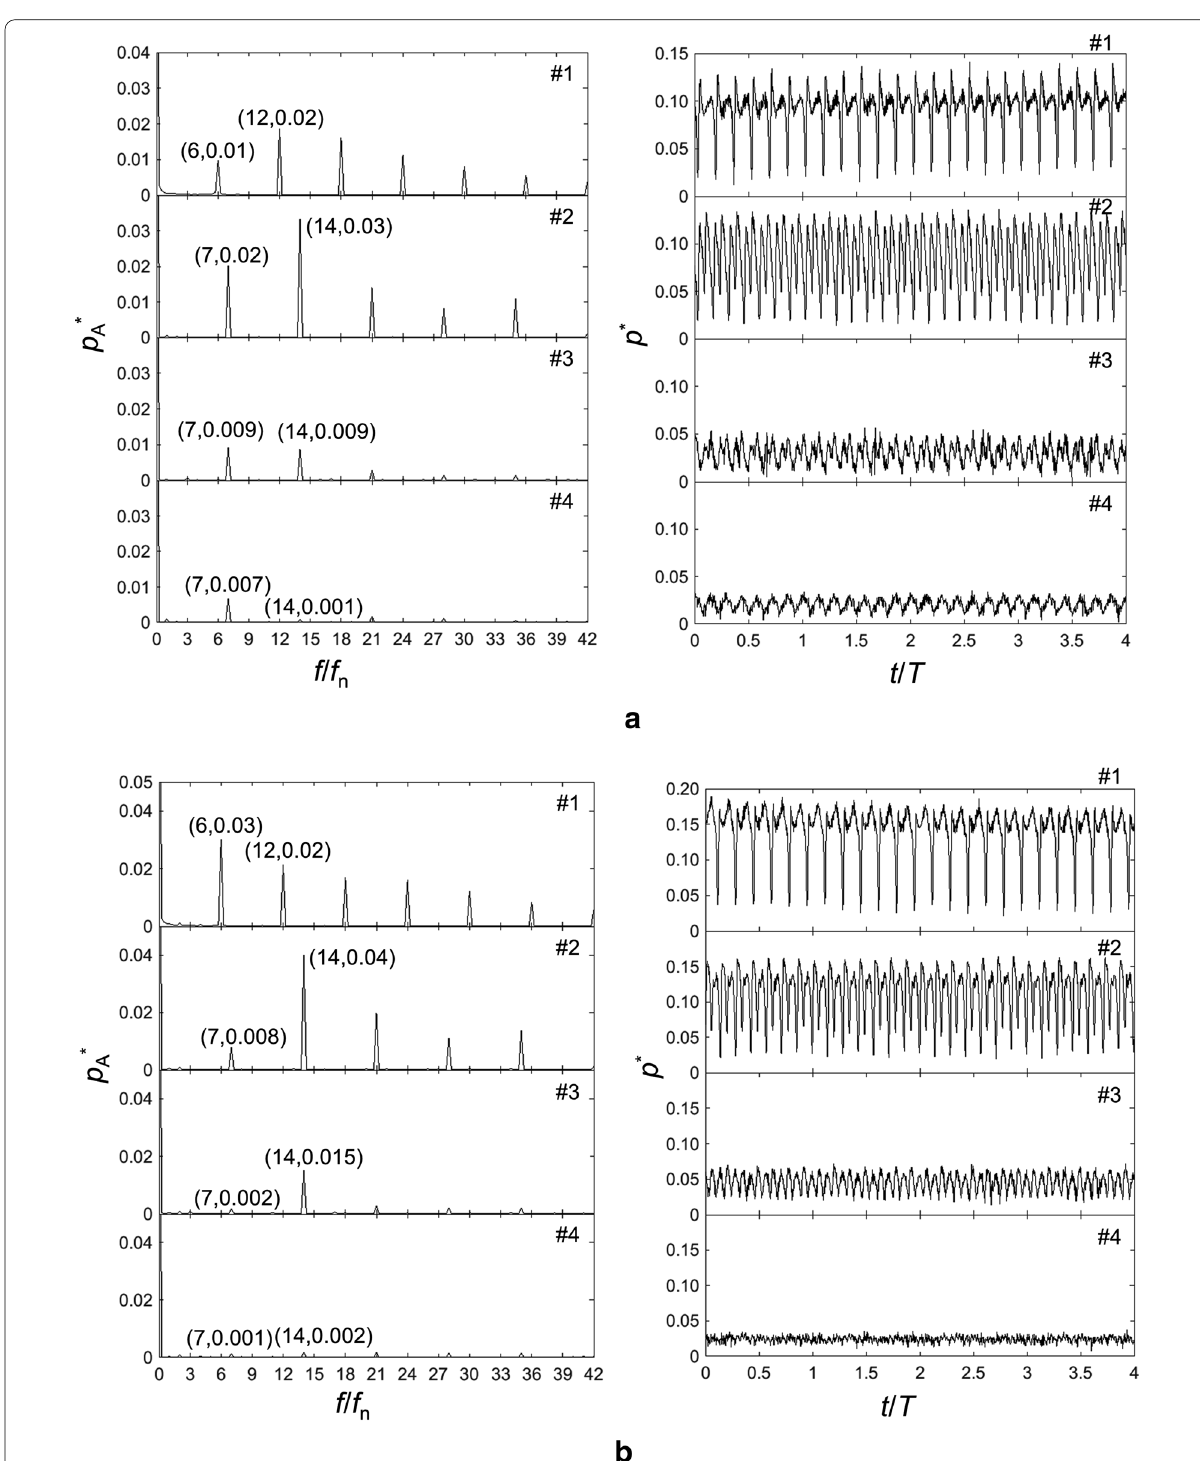
Figure 10 Frequency and time domains of the pressure fluctuation in the volute: a on monitoring point V1; b on monitoring point V3; c on monitoring point V5; ( d ) on monitoring point